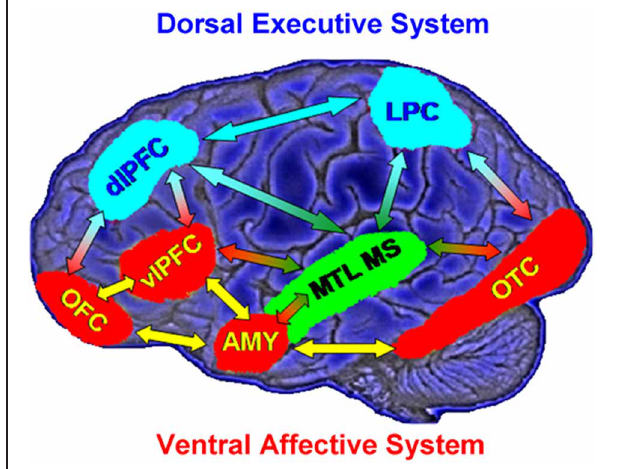
FIGURE 1 | Neural systems involved in cognitive/executive (dorsal) vs. emotional (ventral) processing. The dorsal system includes brain regions typically associated with “cold” executive ( ColdEx ; color-coded in blue) functions, such as the dorsolateral prefrontal cortex (dlPFC) and the lateral parietal cortex (LPC), which are critical to the active maintenance of goal-relevant information in working memory (WM). The ventral system includes brain regions involved in “hot” emotional ( HotEmo ; color-coded in red) processing, such as the amygdala (AMY), the ventrolateral PFC (vlPFC), and the medial PFC. Other brain regions that these systems interact with (MTL MS, OTC) are also illustrated. MTL MS, medial temporal lobe memory system; OFC, orbitofrontal cortex; OTC, occipitotemporal cortex. Note that this diagram does not include all regions that are part of the two systems, as in its present format it does not include medial brain regions. Also, even though the visual cortical areas illustrated here (OTC) are not technically part of the HotEmo system, they are colored in red because they are susceptible to influences from emotion processing regions. Monochromatic arrows represent connections within the same system, whereas bichromatic arrows represent connections across systems. Adapted from figure courtesy of Dr. Lihong Wang and Dr. Aysenil Belger. Reproduced from Dolcos et al. (2011), with